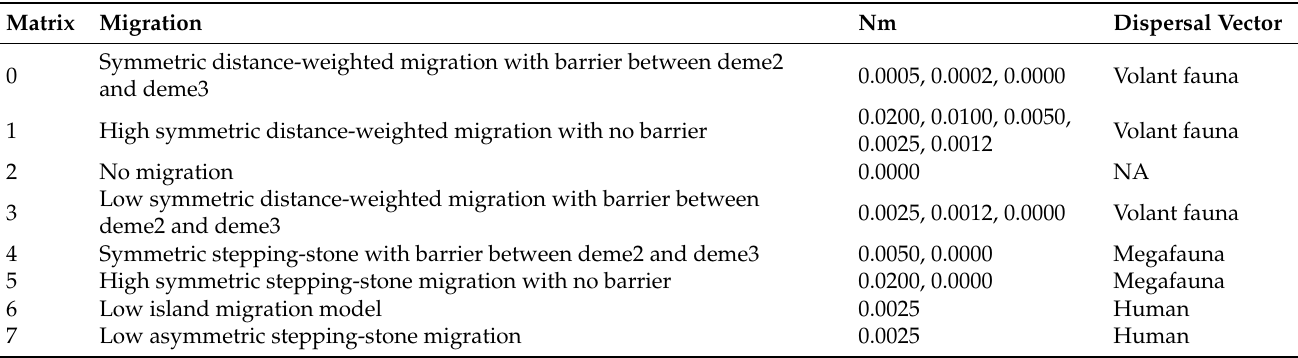
Table A2. Migration matrices employed in simulation